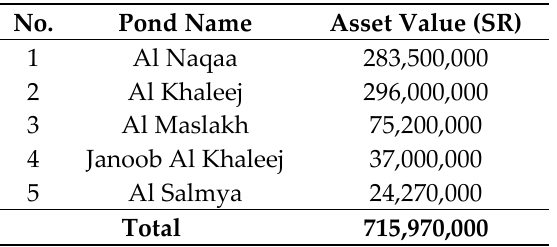
Table A2. Land asset value of existing ponds.